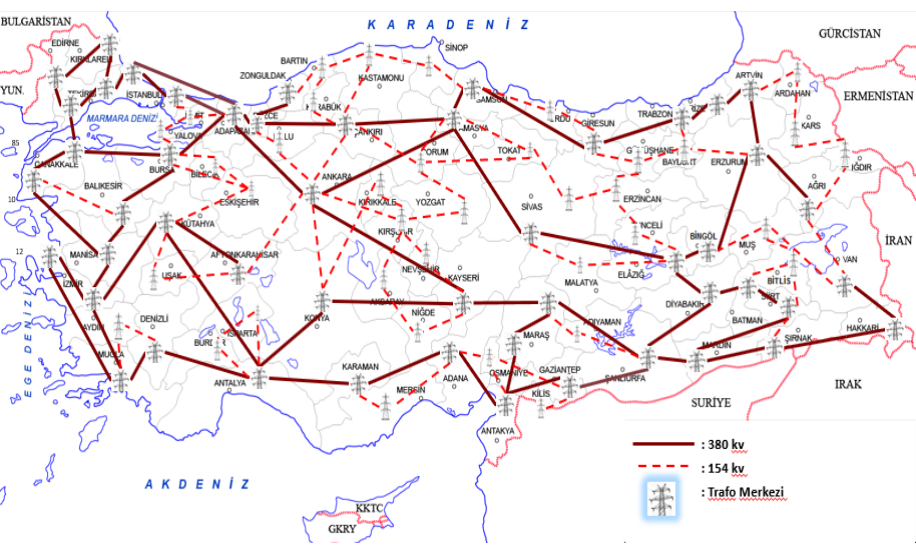
Figure 1. The high voltage transmission system in Turkey as adopted in the case study.